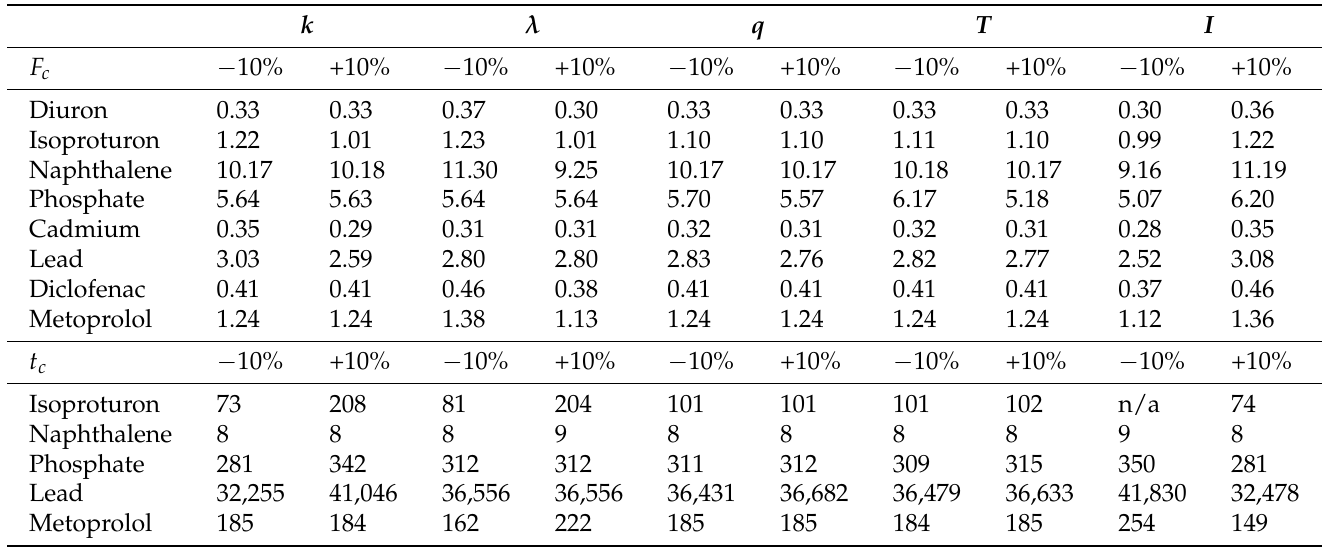
Table 4. The response of the critical sustainability factor F c and critical sustainability time t c in response to decreases and increases of 10% of the adsorption coefficient k , the degradation rate constant λ , the drainage rate q , and the evapotranspiration rate T . The critical sustainability time is only shown for contaminants whose standards are violated, as this parameter is otherwise